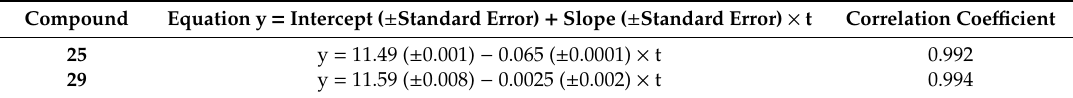
Table 2. Equations of the hydrolysis reactions.